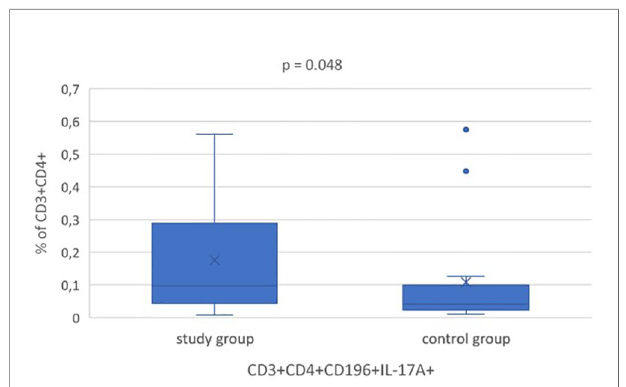
FIGURE 2 | Statistical analysis of Th17 (CD3 + CD4 + CD196 + IL-17A +ic ) cells frequency at baseline in overweight and obese children (study group) and normal weight ones (control group). All box plots represent the minimum, the fi rst quartile, the median, the mean, the third quartile and the maximum. Dots represent